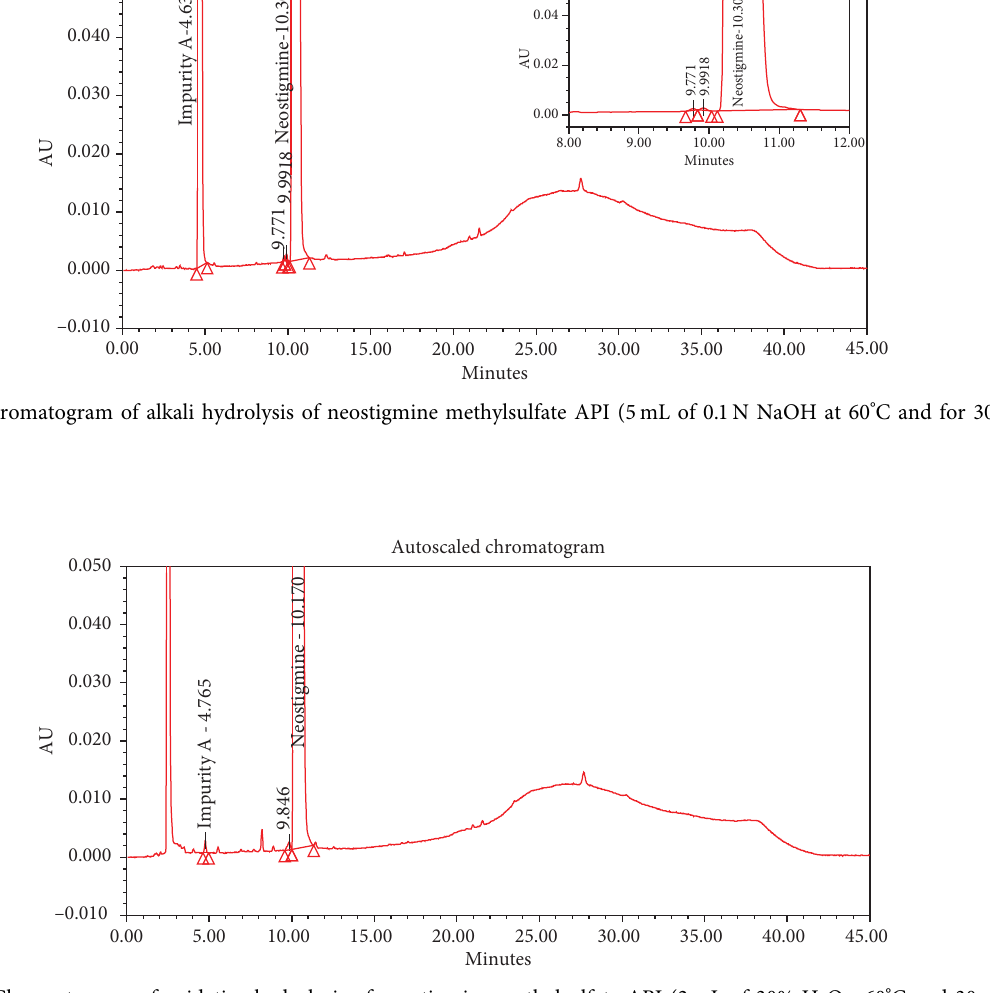
° C and 30min). 2 O 2 , 60